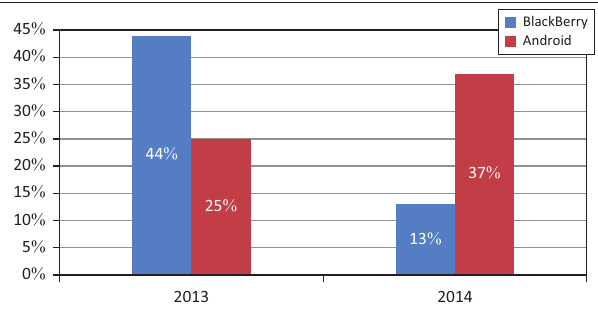
FIGURE 2: Growth of Android adoption from